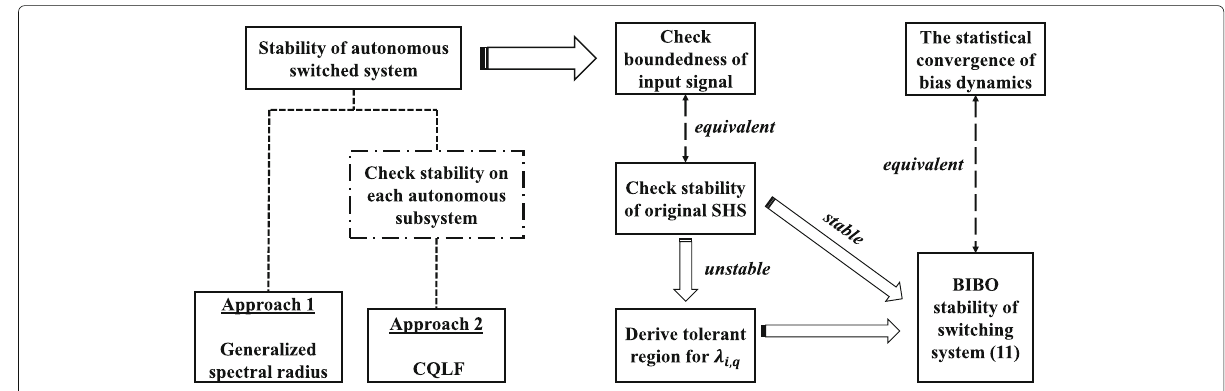
Fig. 2 Stability analysis for the transformed switched